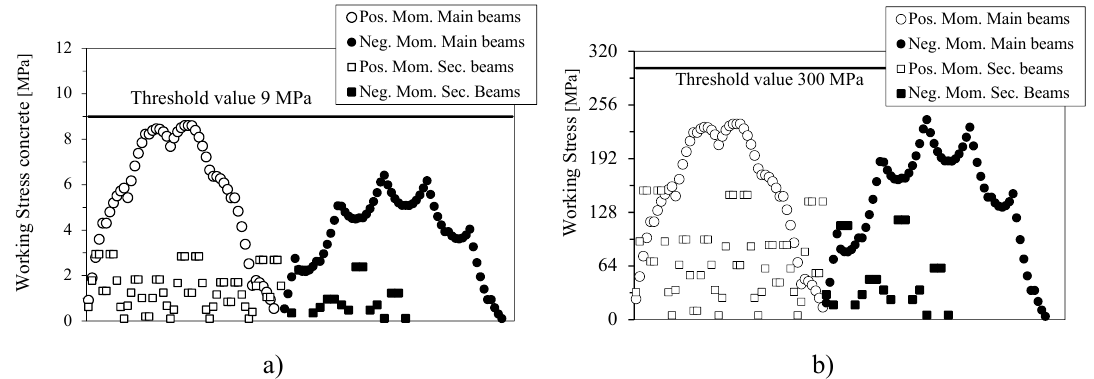
Figure 8. Structural verifications for bending moment in the beams: a) compressed concrete, b) steel reinforcement in